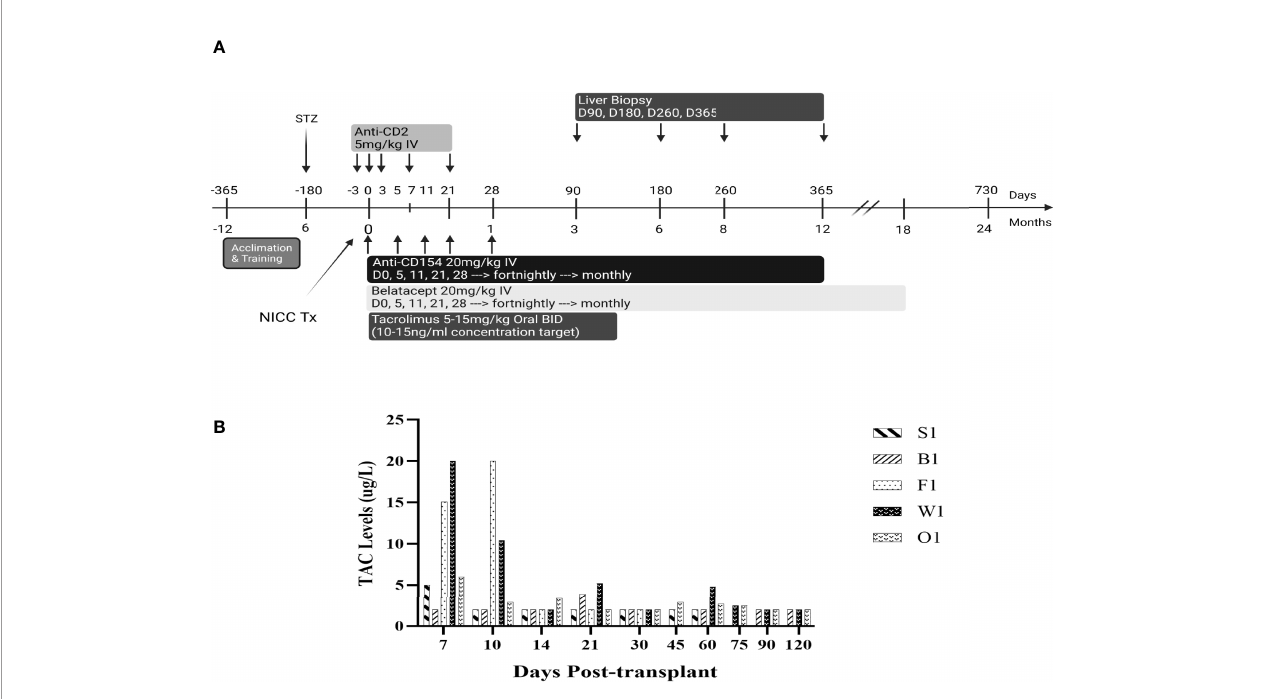
FIGURE 1 | Immunosuppressive and biopsy protocol (A) and Tacrolimus trough levels (B)